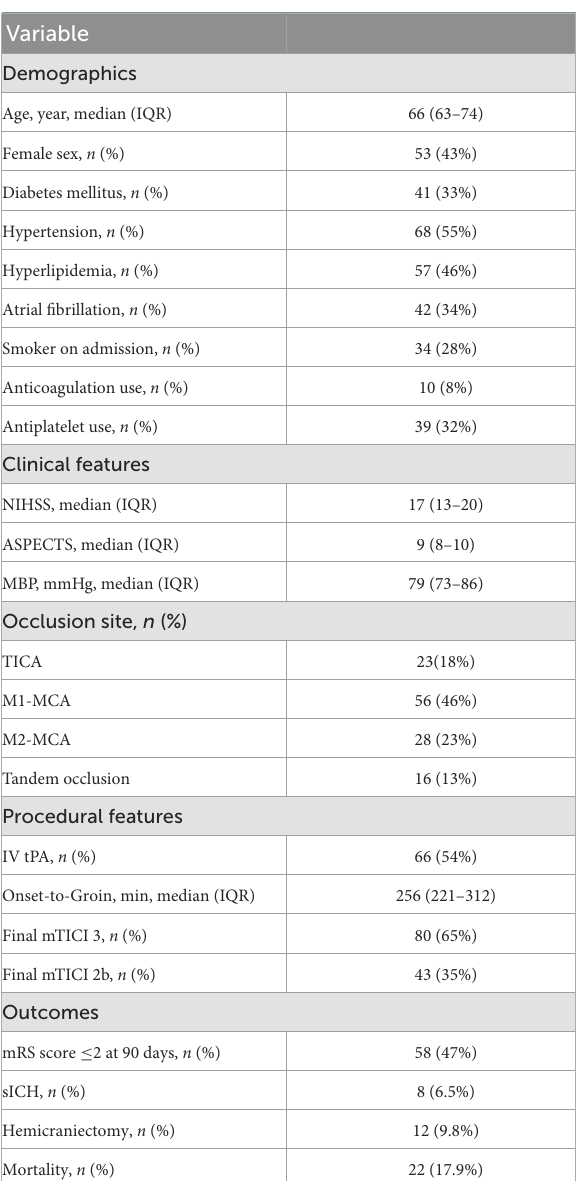
Table 4. After the univariate analysis, hyperlipidemia, atrial fibrillation, NIHSS score, ASPECTS, tandem occlusion, and onset-to-groin puncture time were included in the multivariable analysis. Increased lactate at 8h after EVT was an independent predictor of hemicraniectomy (OR = 2.910, 95% CI: 1.006– 8.419, P = 0.049), as was decreased HCO − levels at 8h after 3 EVT (OR = 0.762, 95% CI: 0.599–0.970, P = 0.027). The